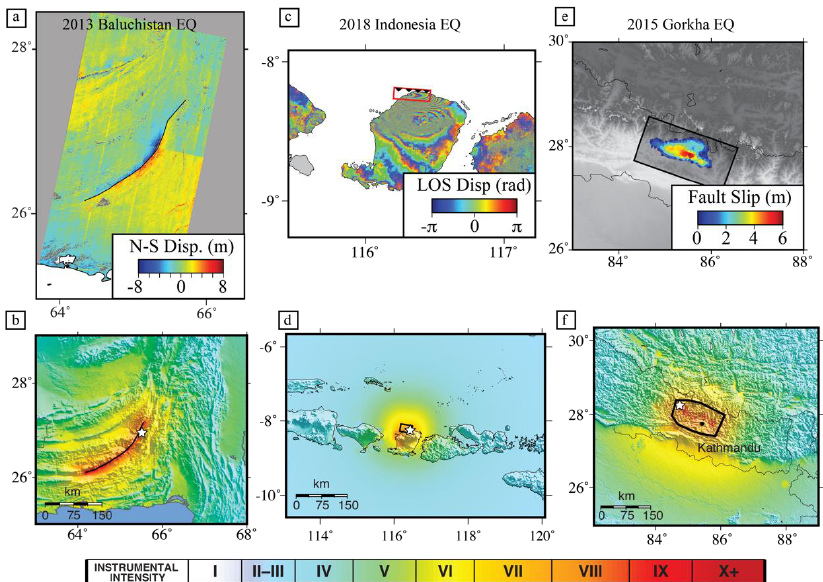
Figure 2. Examples of the various ways geodetic observations and their derivative products (fault trace, fault model, slip distribution) inform USGS NEIC response products. ( a ) Landsat-8 pixel tracking results spanning the 2013 M w 7.7 Baluchistan, Pakistan earthquake. The black fault trace is the surface rupture mapped from the pixel tracking results. ( b ) ShakeMap that is parameterized by the fault trace determined from the pixel tracking results. ( c ) Co-seismic Sentinel-1 interferogram of the 2018 M w 6.9 Lombock, Indonesia earthquake. The single patch fault model inverted from these observations is shown as a red polygon, with the up-dip limit of the fault shown in black. ( d ) ShakeMap of the Lombock earthquake that includes the fault model shown in panel c. ( e ) Co-seismic slip distribution of the 2015 M w 7.8 Gorkha, Nepal earthquake derived from co-seismic GPS and Sentinel-1 and ALOS-2 interferograms. ( f ) ShakeMap of the Gorkha earthquake parameterized by a teleseismic finite fault model constrained in part by the geodetic slip distribution in panel f. The fault slip polygon is shown in black outline. ShakeMap panels are colored by instrument intensity. White starts in panels b, d, and f denote the earthquake epicenter.